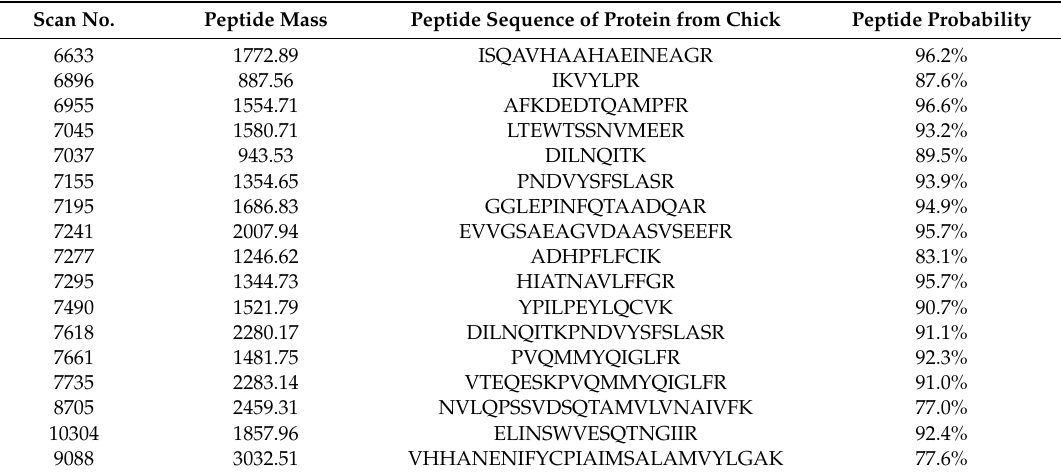
Table 6. The peptide of the OVA purified from top phase of